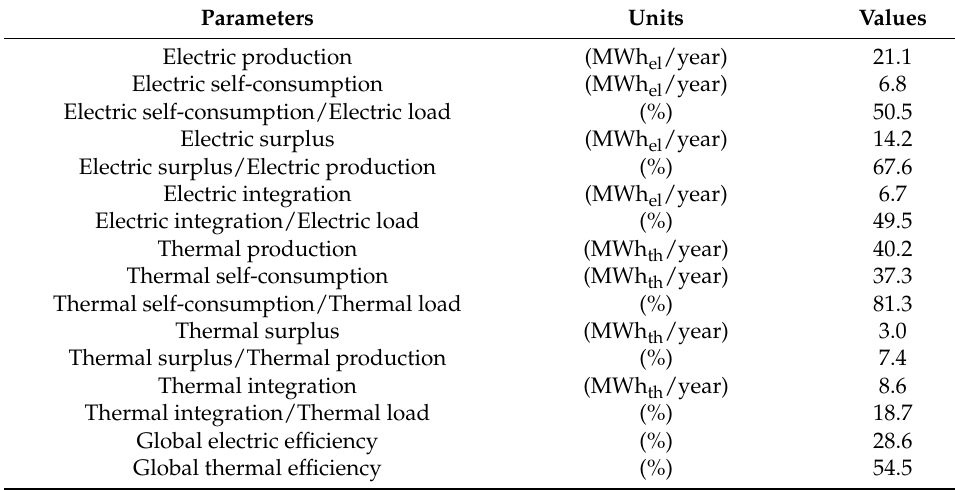
Table 4. Yearly energy performance for the selected